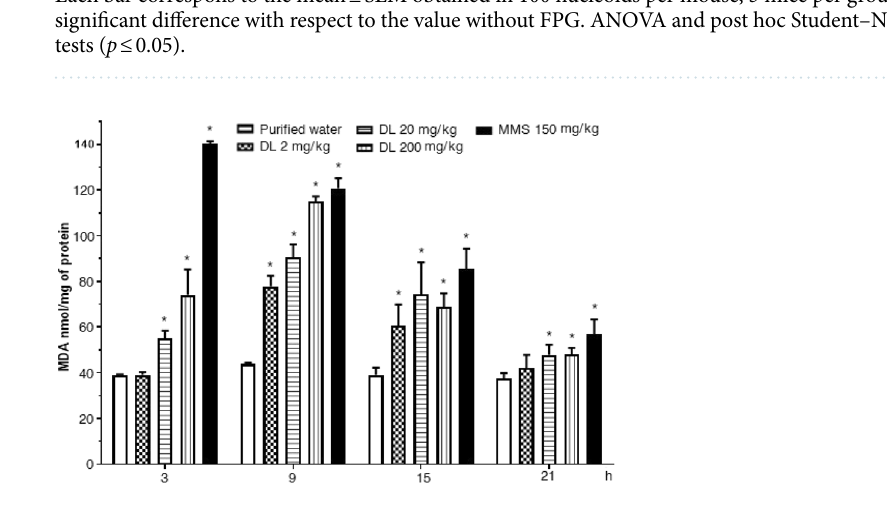
Figure 4. Effect of duloxetine (DL) and methyl metanesulfonate (MMS) on the content of malondialdehyde (MDA) in mouse brain cells. Each bar corresponds to the mean ± SEM obtained in 5 independent determinations made in triplicate. *Statistically significant difference with respect to control value. ANOVA and post hoc Student–Newman–Keuls tests ( p ≤